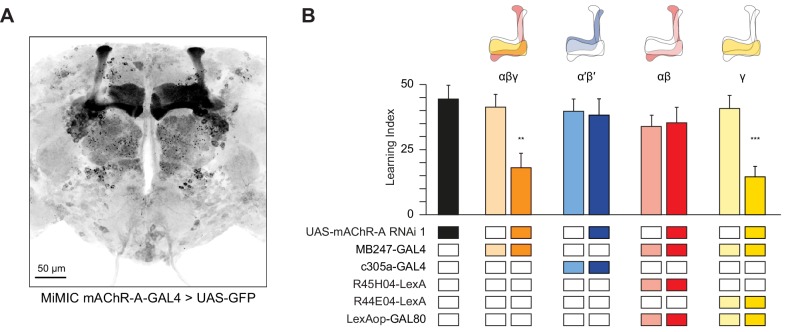
mAChR-A is required for short-term aversive olfactory learning and memory in γ KCs.(A) Maximum intensity projection of 70 confocal sections (2 µm) through the central brain of a fly carrying MiMIC-mAChR-A-GAL4 and 20xUAS-6xGFP transgenes. MB αβ and γ lobes are clearly observed. No GFP expression is observed in α′β′ lobes. (B) mAChR-A RNAi 1 was targeted to different subpopulations of KCs. Learning scores were reduced compared to controls when mAChR-A RNAi 1 was expressed in αβ and γ KCs or γ KCs alone, but not when mAChR-A RNAi 1 was expressed in αβ or α′β′ KCs. (mean ± SEM, n (left to right): 69, 41, 70, 76, 69, 66, 71, 50, 68, **p<0.01, ***p<0.001, Kruskal-Wallis test with Dunn’s multiple comparisons test). For detailed statistical analysis see Supplementary file 1. The data for the UAS-mAChR-A RNAi 1 control are duplicated from Figure 1.10.7554/eLife.48264.011Figure 2—source data 1.Source data for Figure 2.